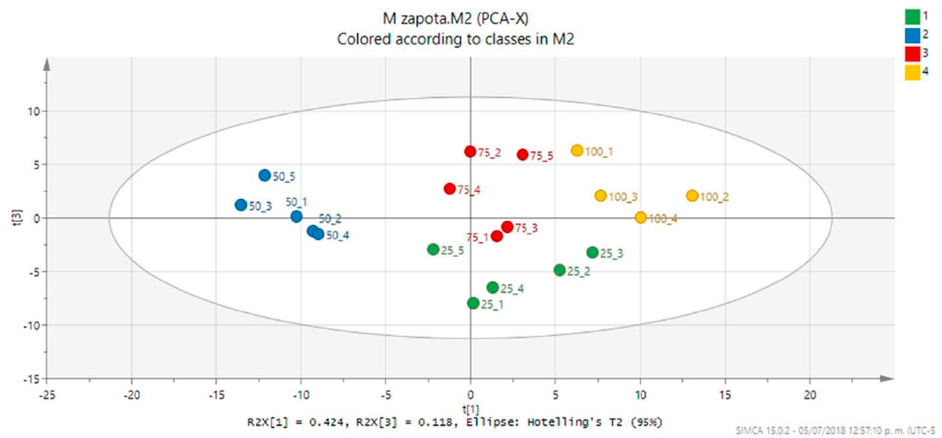
Figure 3. Principal component analysis (PCA) score plot (PC1 vs. PC3, 54.2% of the explained variance) of the M. zapota leaf extracts (MZ25, green; MZ50, blue; MZ75, red; MZ100, yellow). The ellipse represents the Hotelling T2 with 95% confidence in the score plot.